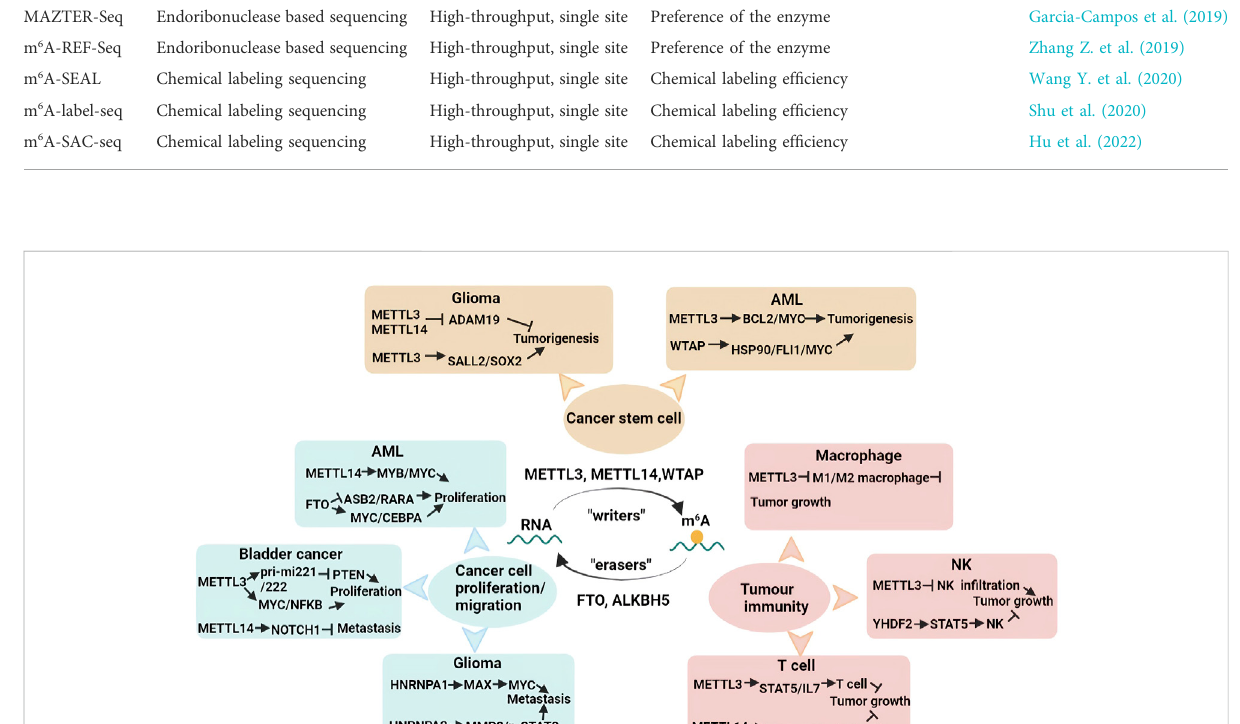
FIGURE 3 Diverse functions of m 6 A RNA methylation in cancers. m 6 A RNA methylation plays a crucial role in tumorigenesis and cancer progression. m 6 A RNA methylation is reversible and is also tightly regulated by “ writers ” and “ readers ” . m 6 A RNA methylation contributes to mediating CSC pluripotency, cancer proliferation, tumour metastasis, and tumor immunity. More details are shown in a graphical